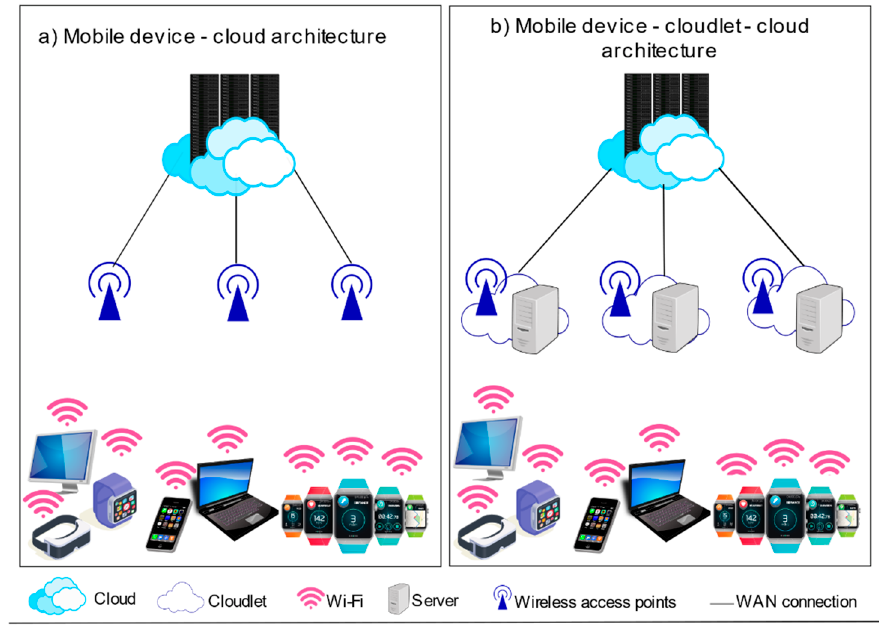
Figure 6. Mobile device–cloudlet–cloud model.